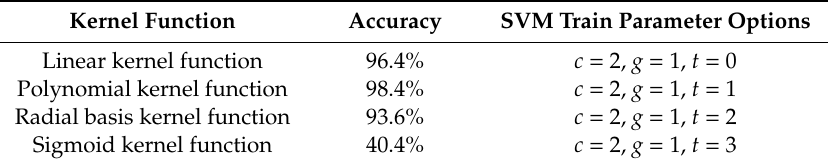
Figure 13. Classification results of SVM kernel function. ( a ) Linear kernel function, ( b ) Polynomial kernel function, ( c ) Radial basis function, ( d ) Sigmoid kernel function. Table 3. Results analysis of different kernel functions in C -SVM.